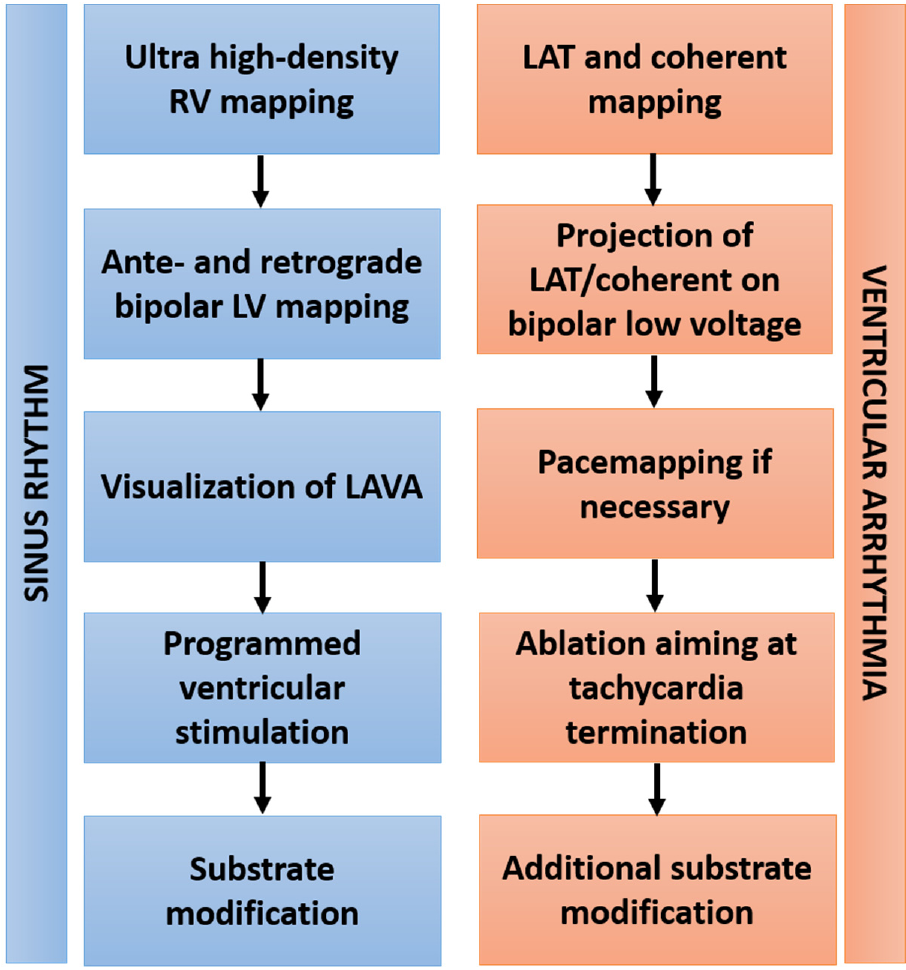
Figure 1. Workflow of VA ablation. Abbreviations: RV—right ventricle; LV—left ventricle; LAVA—local abnormal ventricular activation; LAT—local activation time.